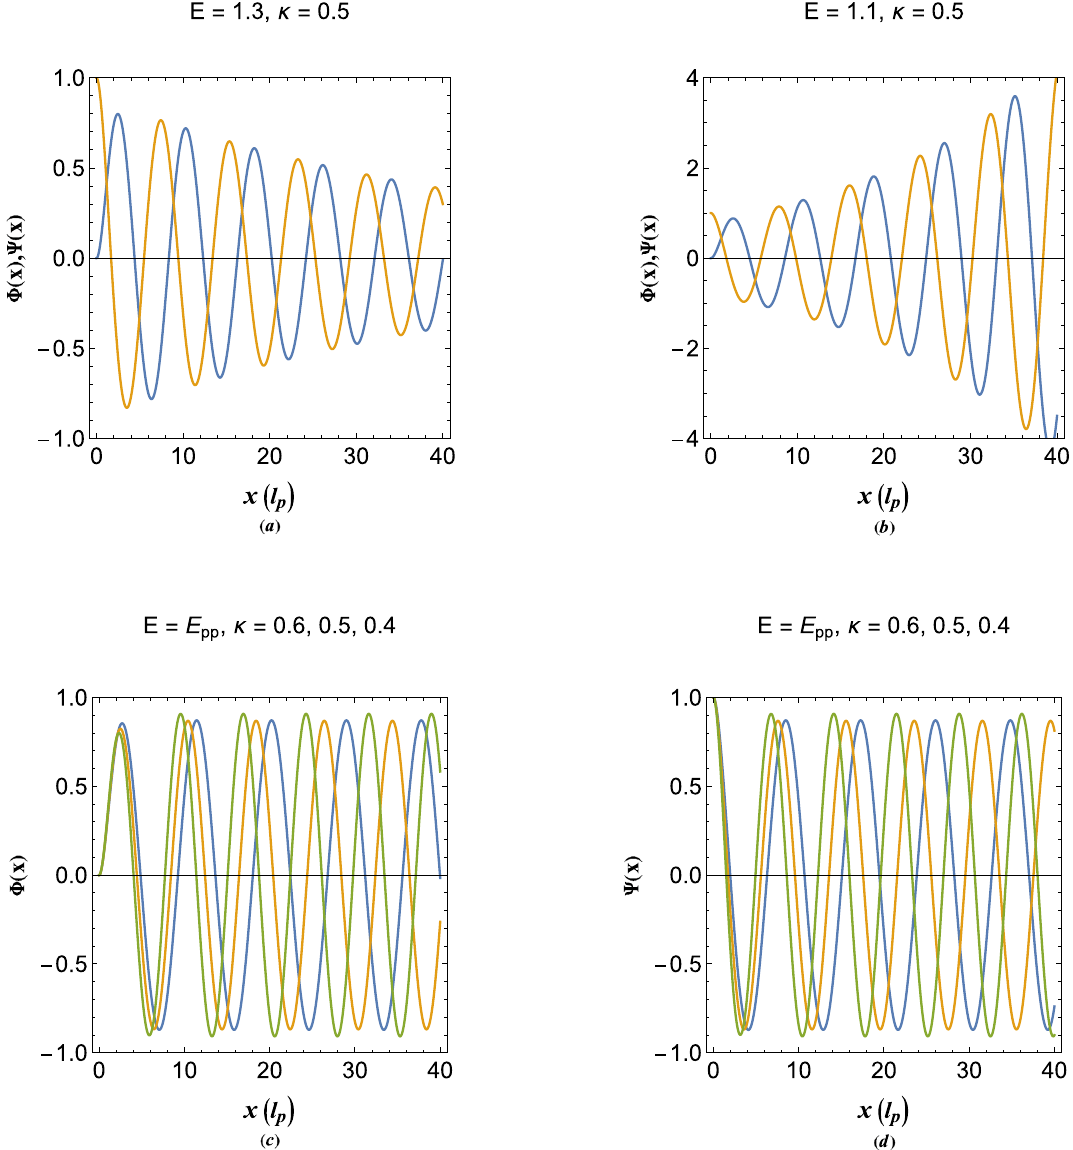
Figure 8. ( a ) The decaying unstable collective oscillation profiles of the local electron density and electrostatic energy of dampes plasmons at energy orbital below the main exceptionl point, E = 2 . ( b ) The growing unstable collective oscillation profiles of the local electron density and electrostatic energy of damped plasmons at energy orbital below the main exceptional point, E = 2 . ( c ) The stable collective oscillation profiles of the electrostatic energy of damped plasmons at resonant orbital below the main exceptionl point, E = 2 . ( d ) The stable collective oscillation profiles of the electron density of damped plasmons at resonant orbital below the exceptionl point, E = 2